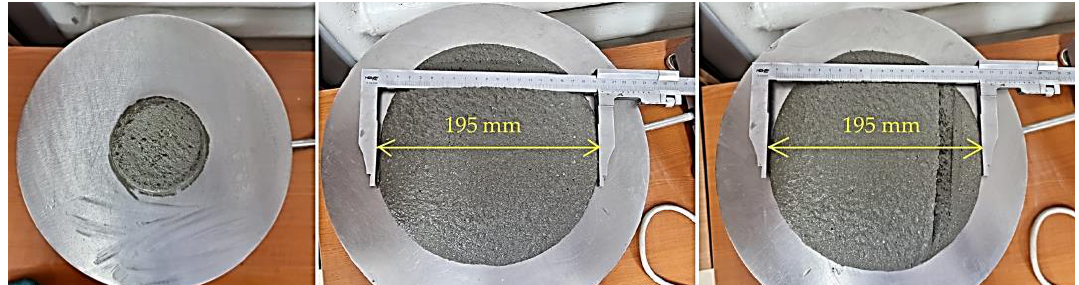
Figure 12. Determination of consistency with the flow table.